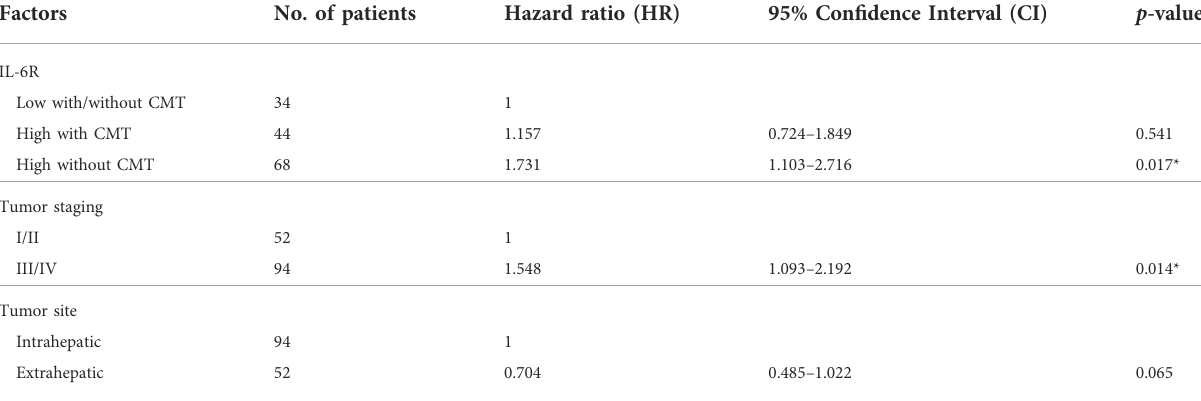
TABLE 2 Multivariate analysis of factors predicting overall survival of CCA